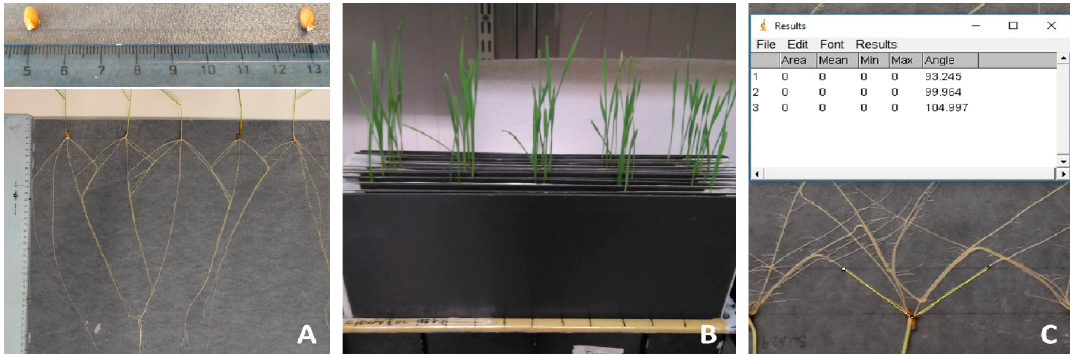
Figure 1. Experimental setup for the analysis of seminal root traits. Seeds were placed 8 cm apart on on moist filter paper ( A ) and kept in a box with distilled water in a growth chamber for 14 days moist filter paper (A) and kept in a box with distilled water in a growth chamber for 14 days at 22 °C under a 16-h light photoperiod (B) . (C) Example of seminal root angle measurement, using ImageJ software.